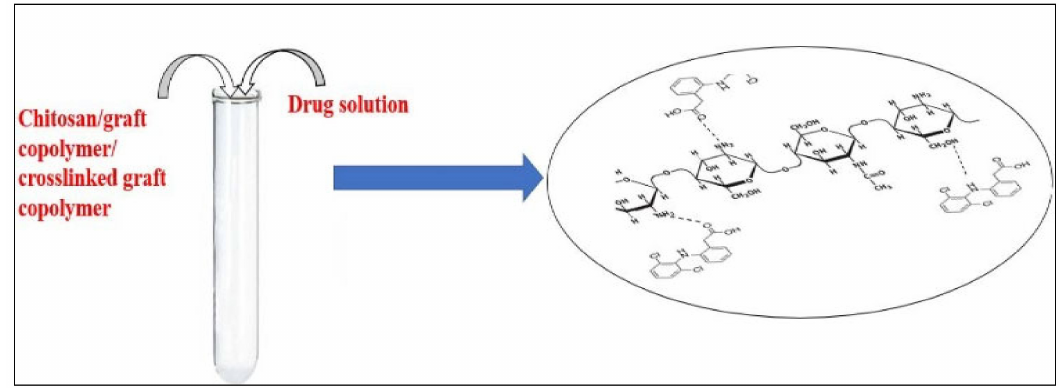
Figure 6. Drug-polymer